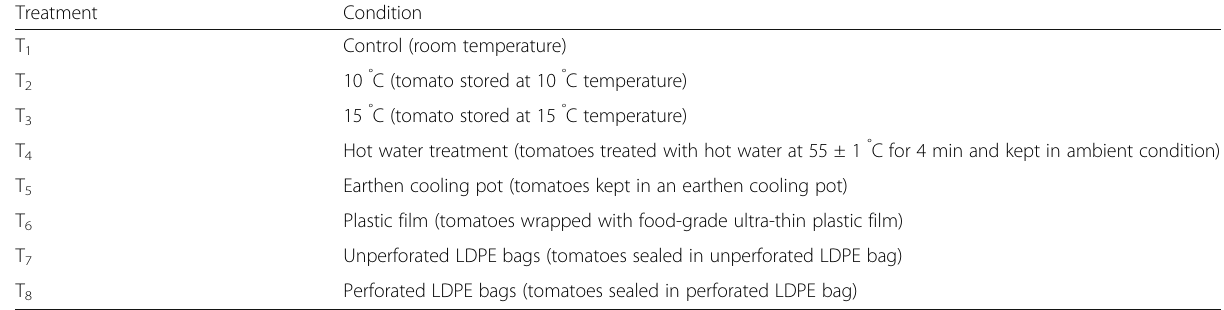
Table 2 Different treatments following in experiment Treatment